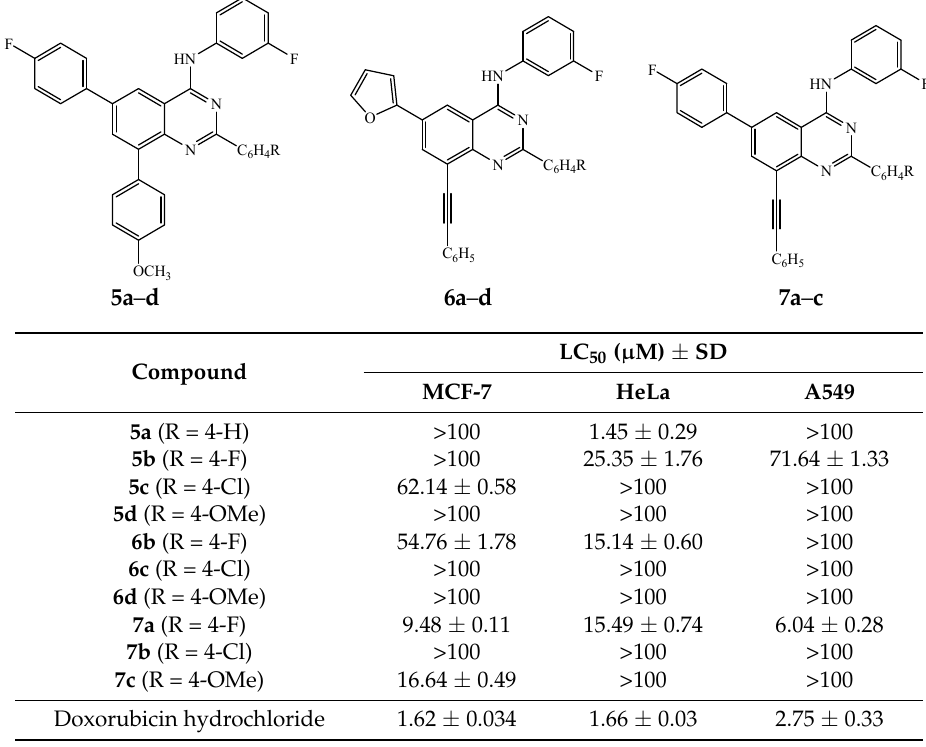
Molecules 2016 , 21 , 1366 Table 8. Cytotoxic effects of 5a – d , 6a – d and 7a – c against MCF-7, HeLa and A549 cell lines.